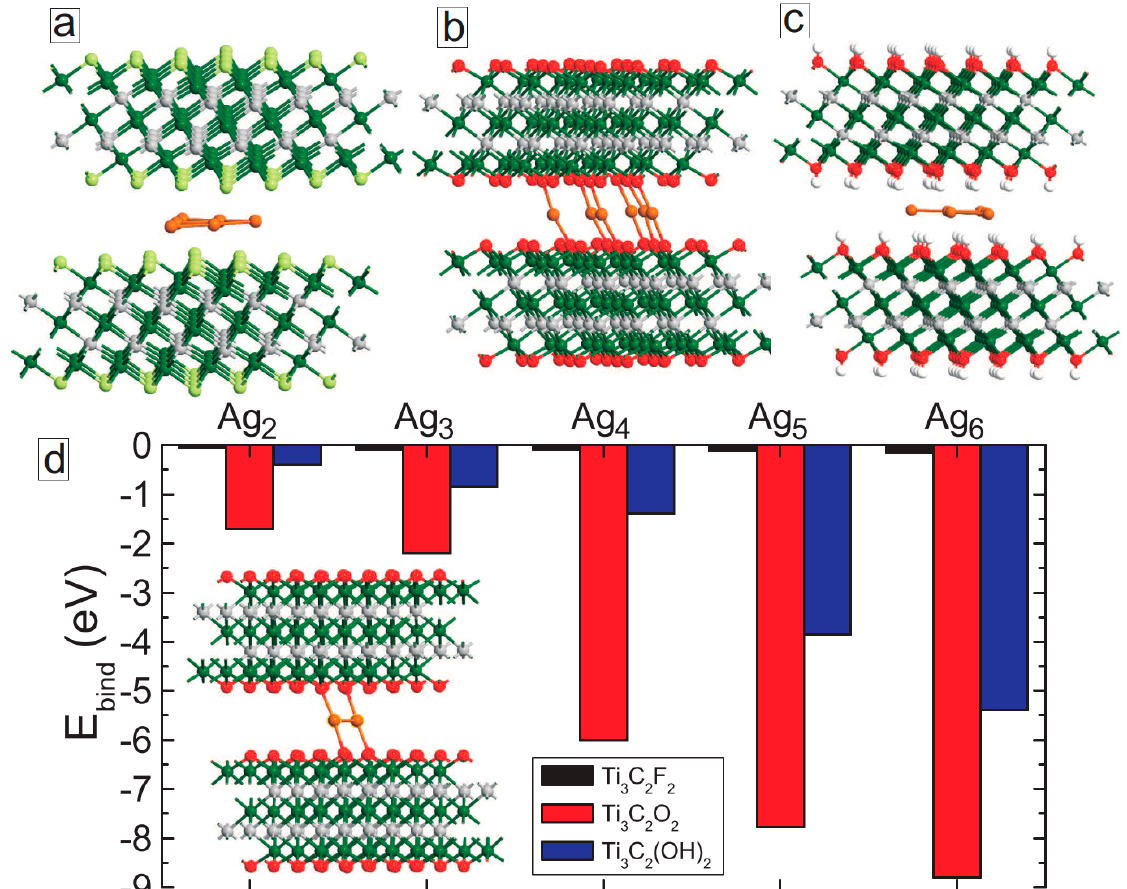
Figure 7. ( a – c ) Optimized structures of Ti 3 C 2 F 2 ( a ), Ti 3 C 2 O 2 ( b ) and Ti 3 C 2 (OH) 2 ( c ) bilayer MXene structures with Ag 6 nanocluster intercalation. ( d ) Binding energies of MXene layers for different Ag n nanoparticles. Inset in ( d ) shows the optimized structure of Ti 3 C 2 O 2 MXene bilayer with Ag 2 nanocluster between the Table 2. MXene–MXene interlayer spacings (Å) for different Ag clusters.